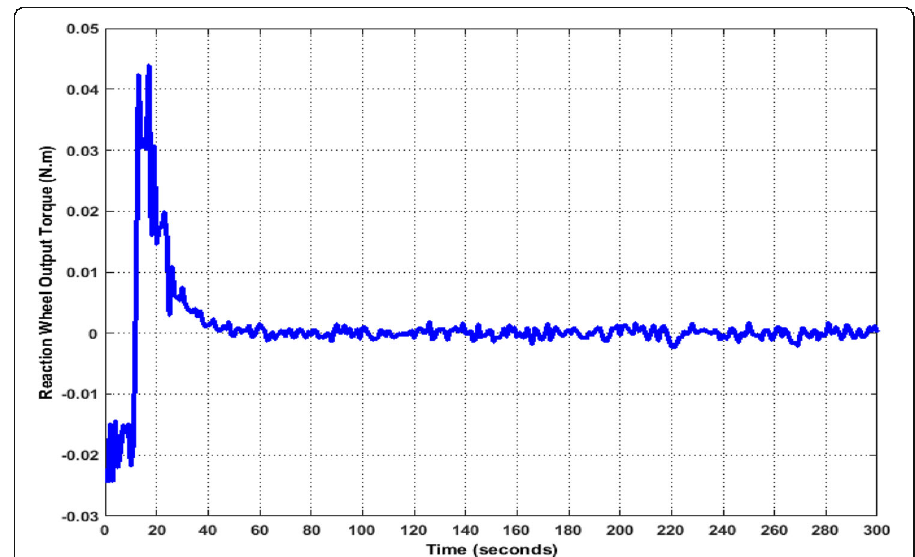
Fig. 5 Reaction wheel output torque